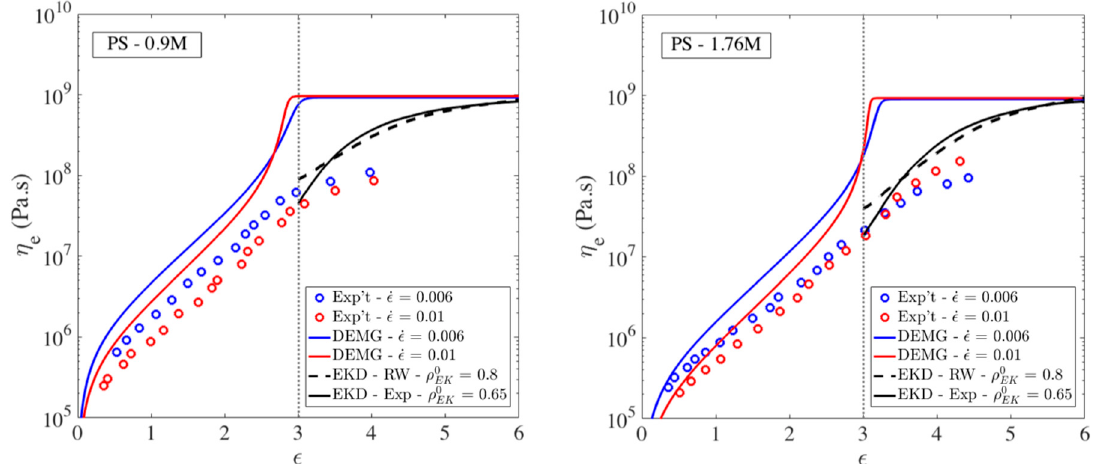
Figure 20. Comparison of uniaxial extensional experimental data [22,49] (o) for 33 wt % 0.9M polystyrene (PS) (left) and 18 wt % 1.76M PS with predictions of the DEMG model and the entangled kink dynamics (EKD) model using the random walk (RW) model for the initial distribution of strand lengths and 𝜌 (cid:3006)(cid:3012)(cid:2868) = 0.8% (dashed line) and using the exponential strand length distribution (Exp) with 𝜌 (cid:3006)(cid:3012)(cid:2868) = 0.65 (solid line). The EKD predictions are in both cases plotted starting from the transition strain of 𝜖 (cid:3021) = 3 .